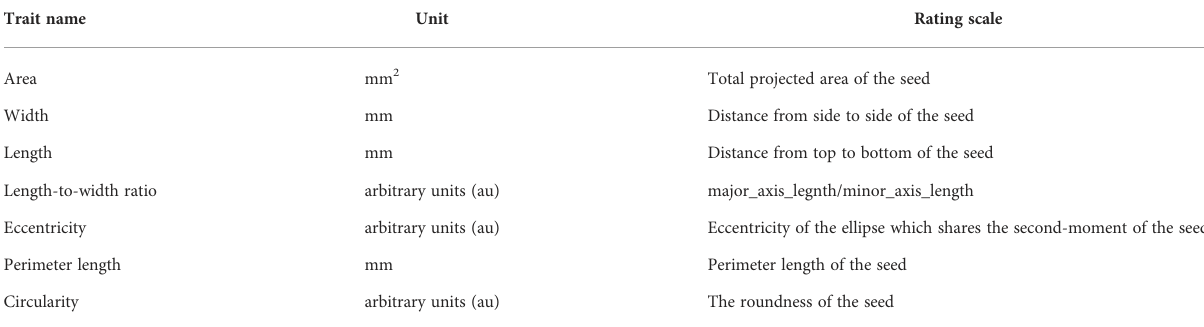
TABLE 1 Traits measured on the parental cultivars and the F 2 population derived from the ‘ Oilseed ’ × ‘ UenoyamaMaruba ’ cross.